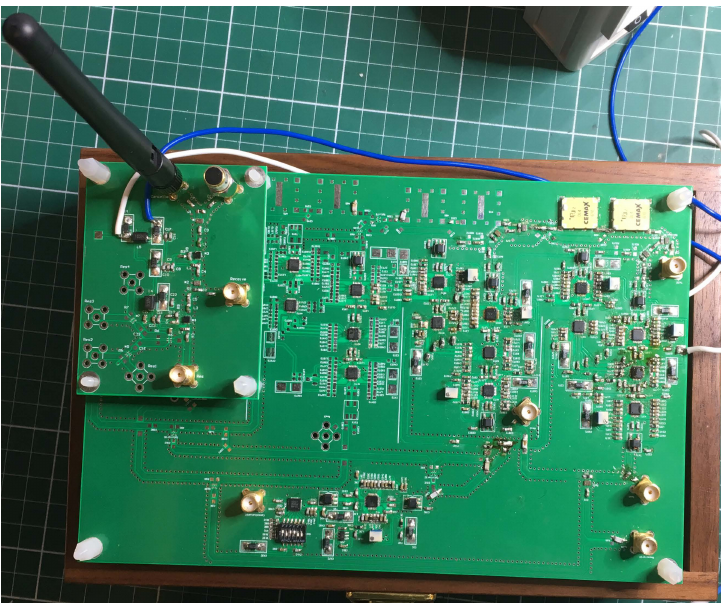
Figure 5. Prototype of the ALMS loop and a part of the